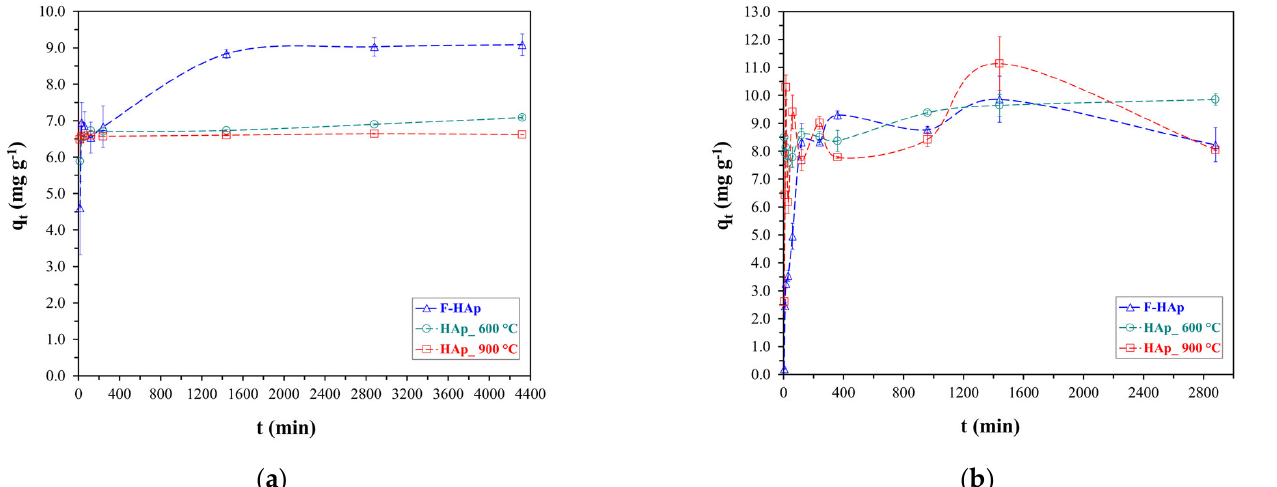
Figure 6. Variation of adsorption capacity versus time for ( a ) atrazine and ( b ) cobalt adsorption. Due to the different nature of the two water contaminants, equilibration time turned out to be quite different. Considering the full three-set of samples, equilibrium was reached after approximately 1600 min (26.7 h) for atrazine, while it took around 400 min (3.7 h) for cobalt adsorption to stabilize (by taking into account experimental errors). HAp_600 ◦ C and HAp_ 900 ◦ C (about 6.5 mg g − 1 ), although more time was needed